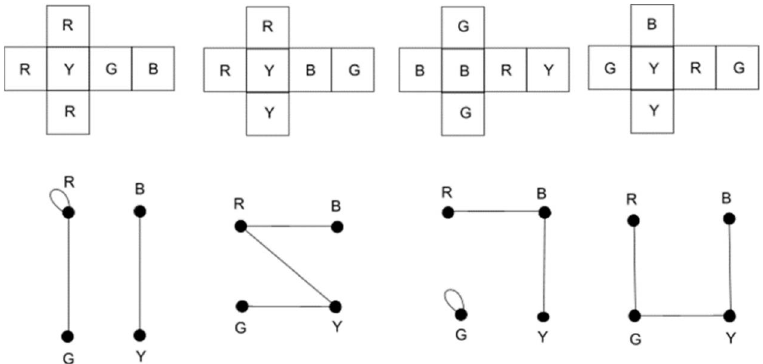
Figure 2. Alternative representations of the four-cubes problem in terms of graphs.